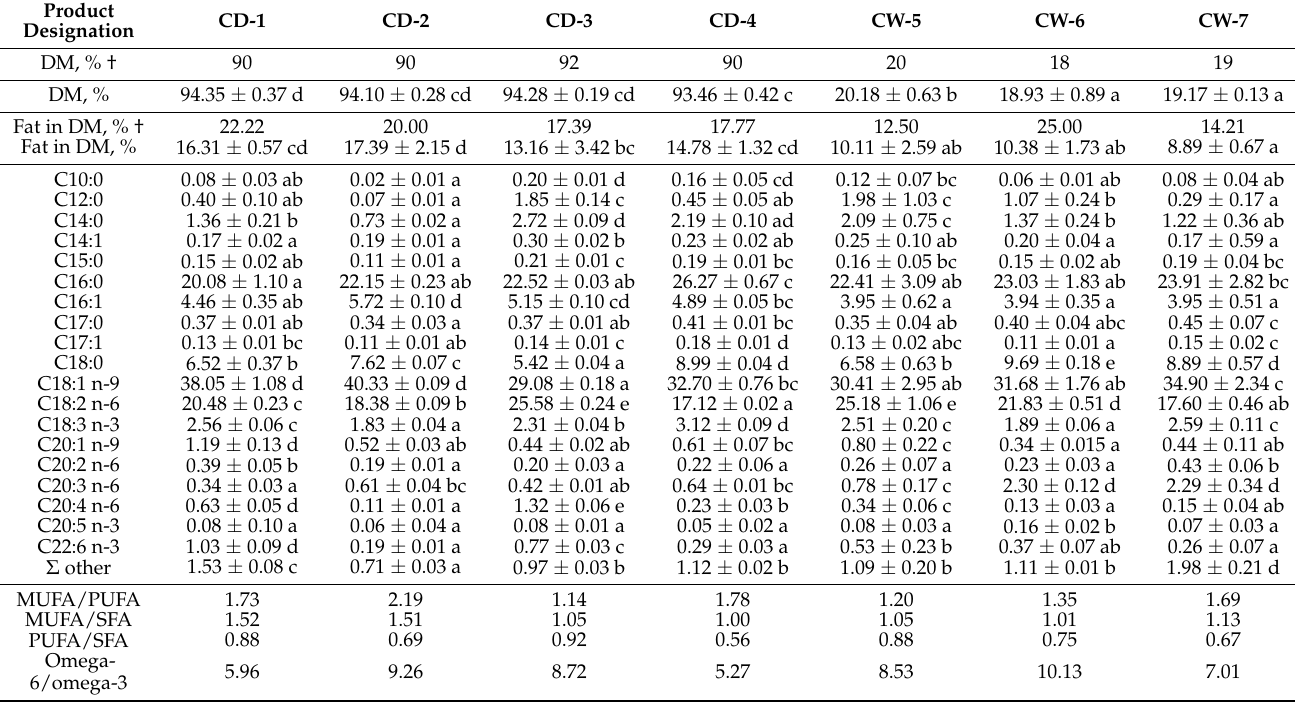
Table 2. Main animal ingredients: dry matter (DM), fat content and fatty acid composition (%) in fats extracted from tested commercial dry (CD) and wet (CW) cat